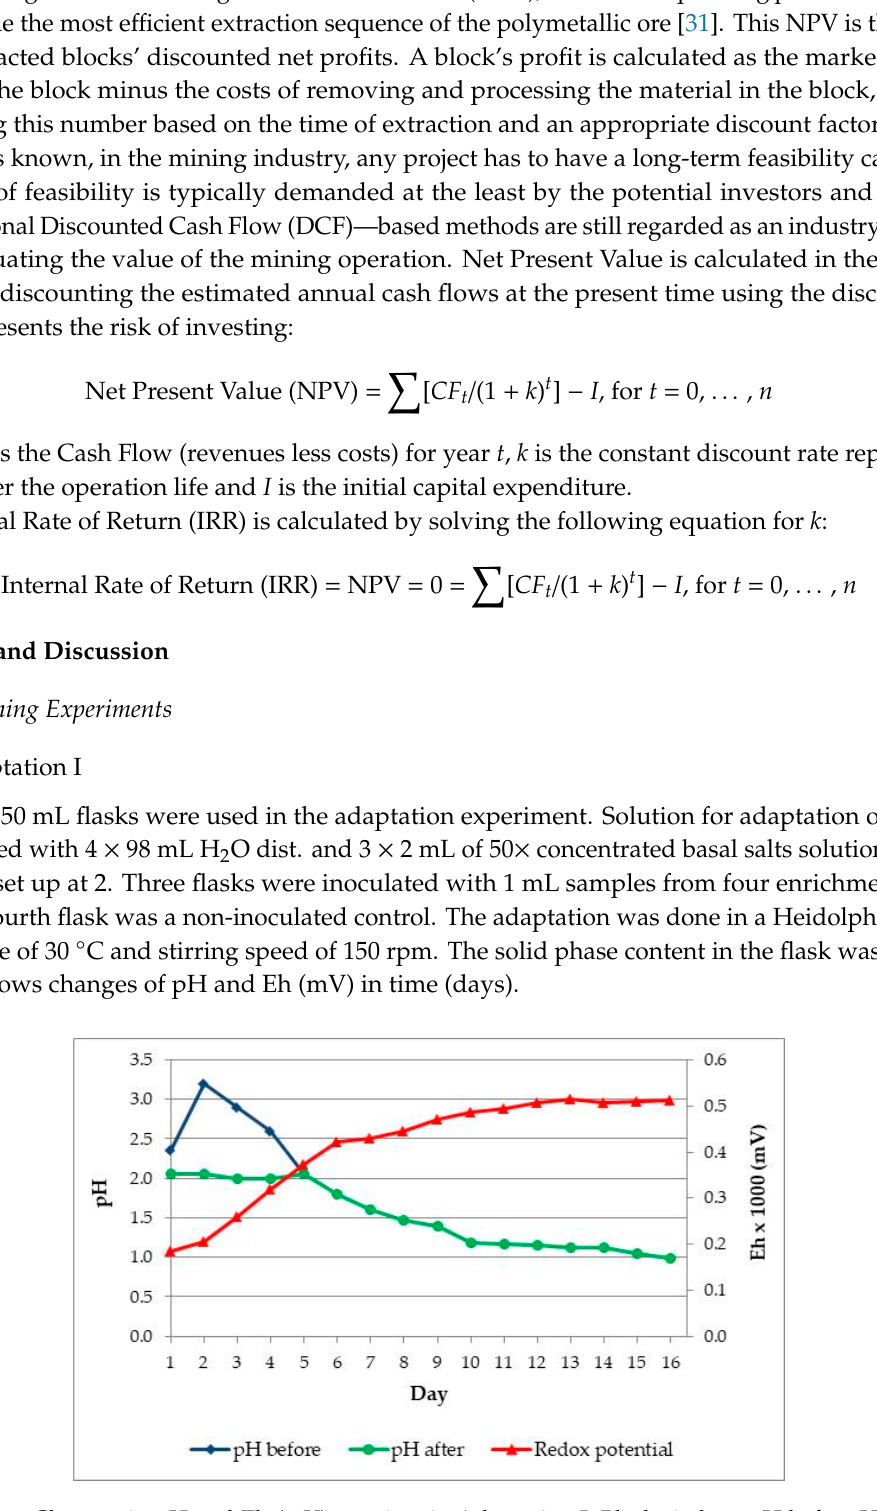
Figure 3. The changes pH and Eh (mV) vs. time in Adaptation II. Black circles—pH before H 2 SO 4 addition; blue squares—pH after H 2 SO 4 addition; red triangles—Eh (mV). For the reason increased the pH value, in first four days, it was adjusted using sulphuric acid to the initial value pH = 2. 3.1.3. Adaptation III After the second adaptation experiment, 1 mL of bacterial cultures was once again transferred to flasks with fresh medium and ore samples. The content of solid in solution was increased to 10% ( w / v ). Temperature and stirring speed were constant. Figure 4 shows changes of pH and Eh (mV) during third adaptation experiment. The pH value is also adjusted using sulphuric acid to the initial value pH = 2 in first four days.